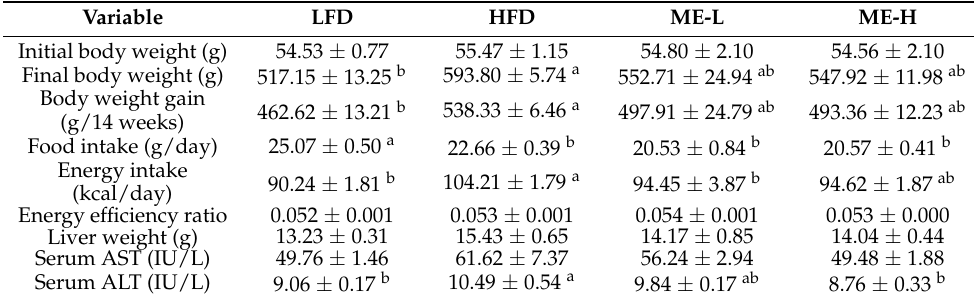
Table 1. Physiological variables.